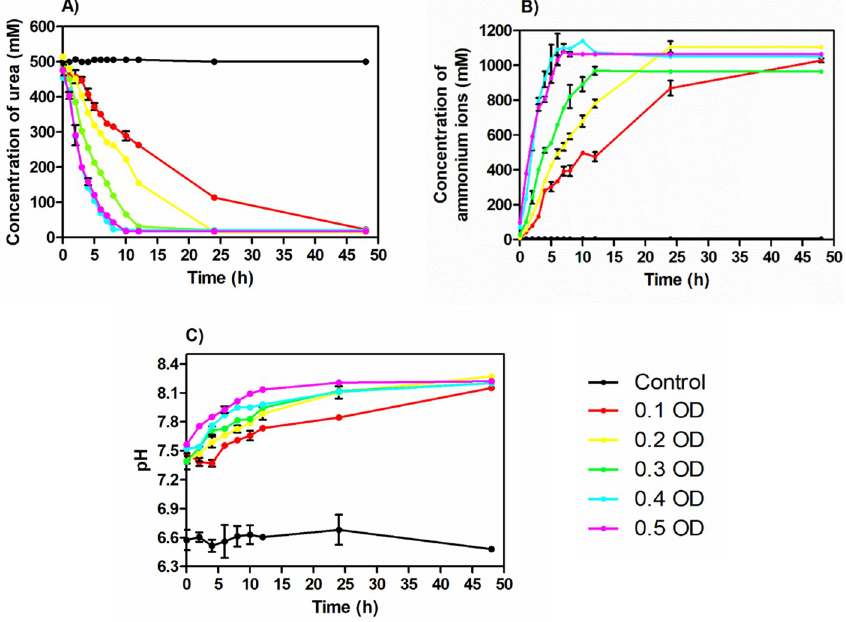
Fig 1. The concentration of urea (A), ammonium ions (B), and pH (C) over time.